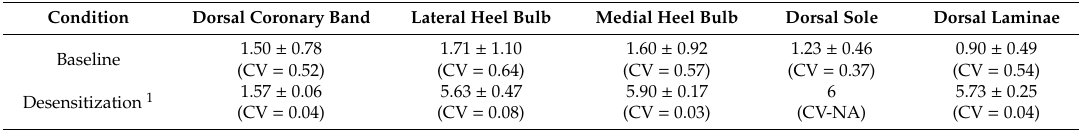
Table 13. Mean MNTs (kgs) for perineural analgesia of the palmar digital nerves